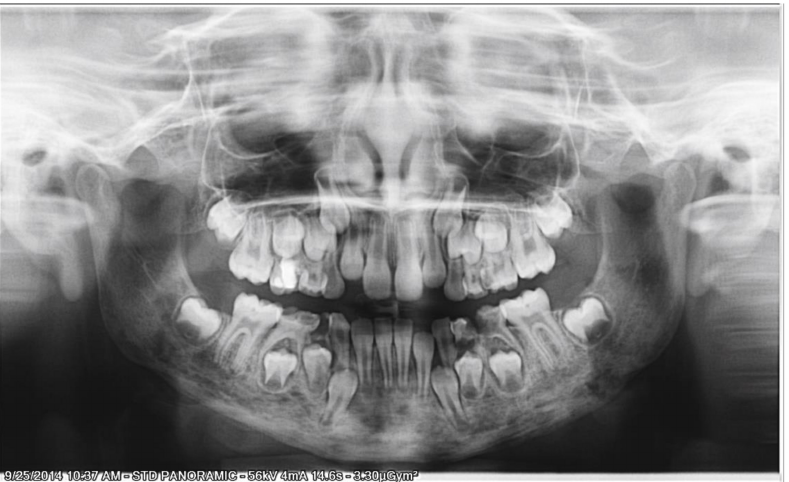
Figure 1. Initial Cone beam computed tomography (CBCT) examination shows osteolytic and sclerosis lesions (“onion skin”); A—sagittal sections through the body and ramus of the mandible; B—cross sections through the body of the mandible.